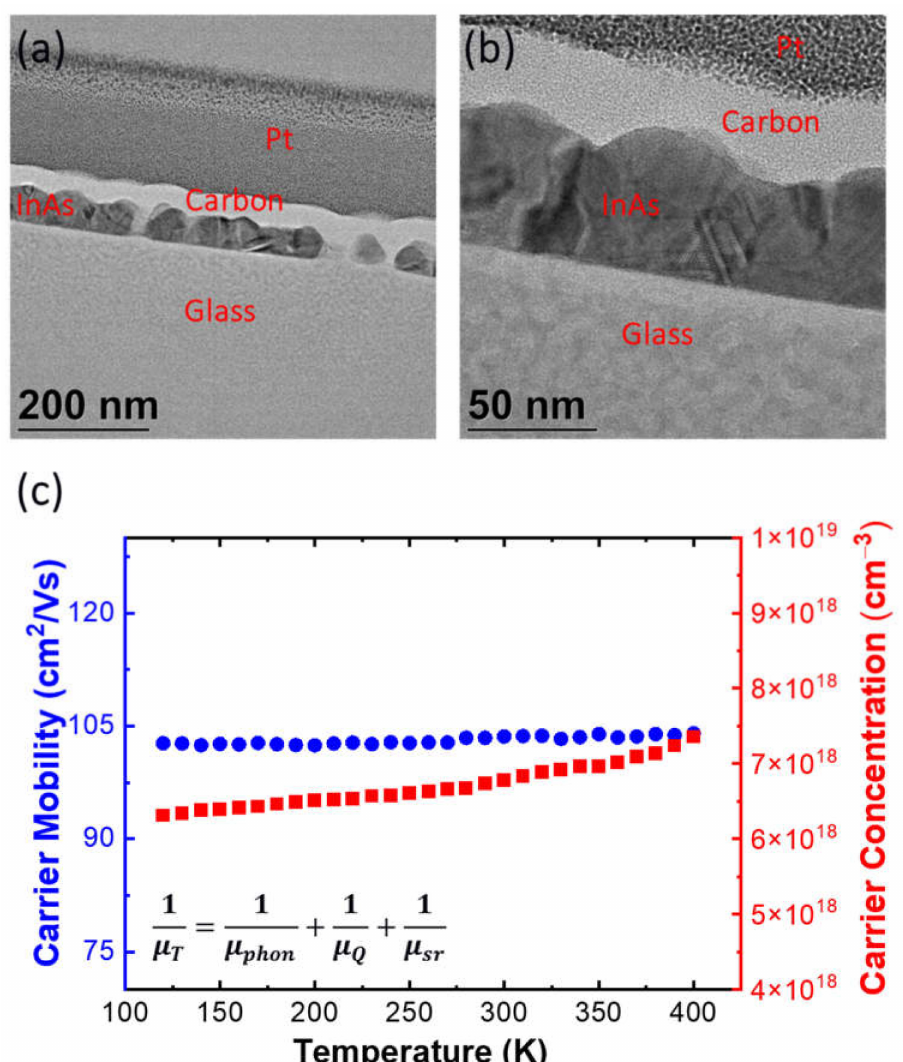
Figure 1. ( a , b ) Cross-sectional TEM images of polycrystalline InAs film grown at 475 ◦ C directly on a glass substrate. ( c ) Temperature-dependent Hall effect measurements of a nominally 25 nm poly InAs film on glass (inset: contributions to the overall electron mobility, see text). Measurements taken in AC mode with magnetic field of 0.6